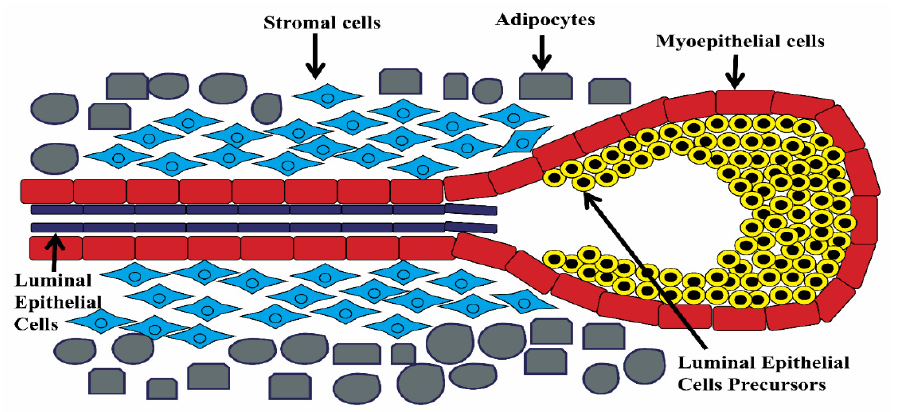
Figure 4. Schematic diagram representing the terminal end bud (TEB).